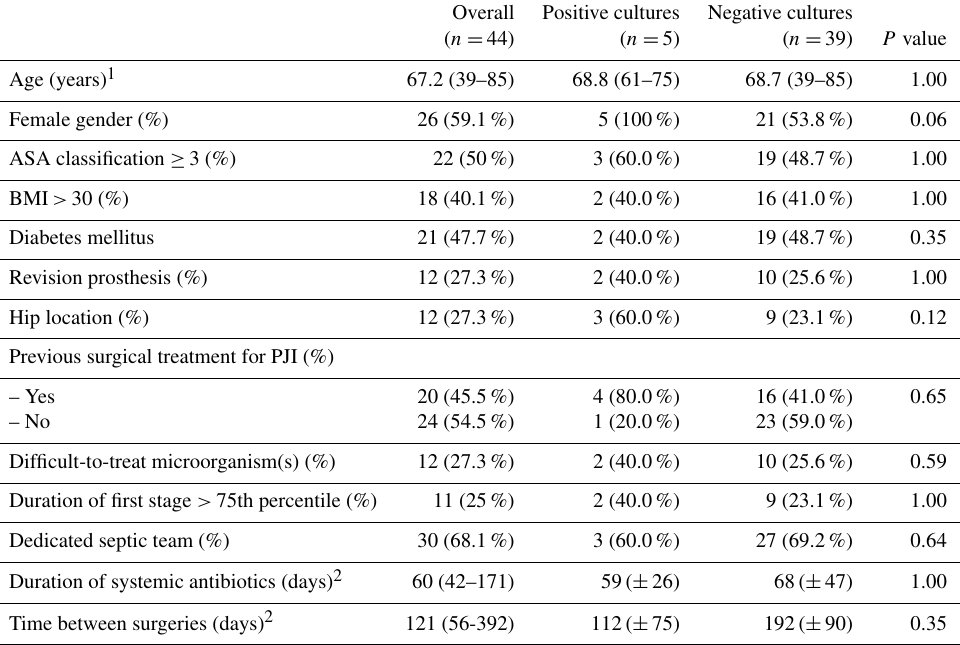
Table 4. Analysis of risk factors for positive cultures in the second-stage surgery among patients with combined antibiotics in spacer. Overall Positive